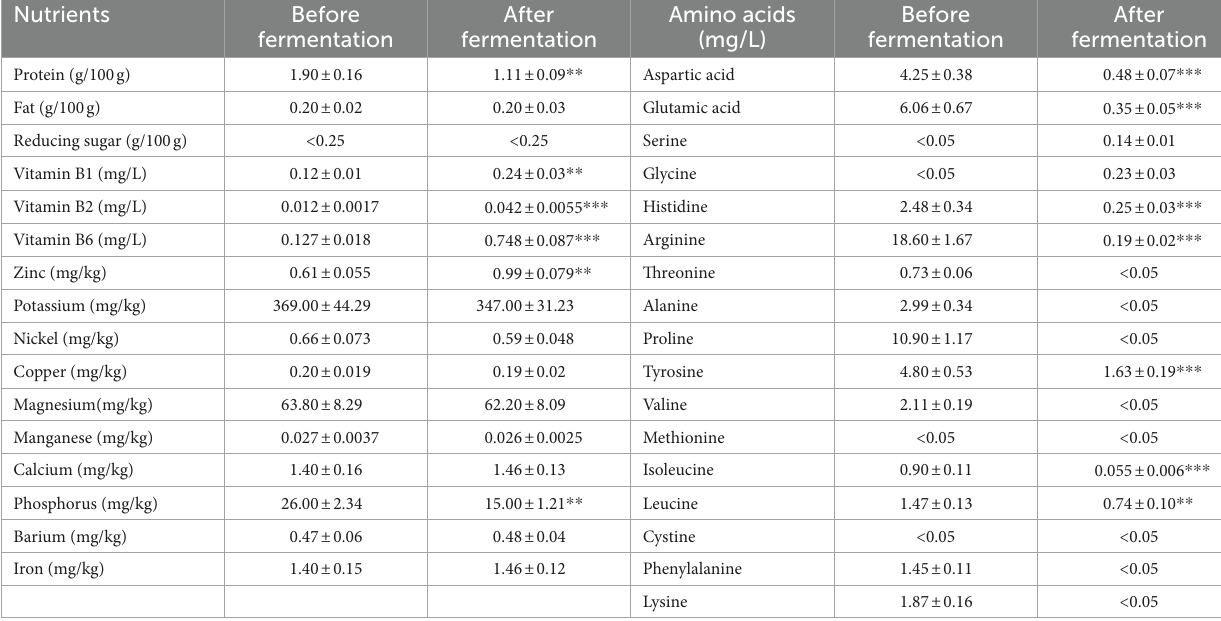
TABLE 4 The effect of Rhodotorula glutinis on the nutrient content of TWW.